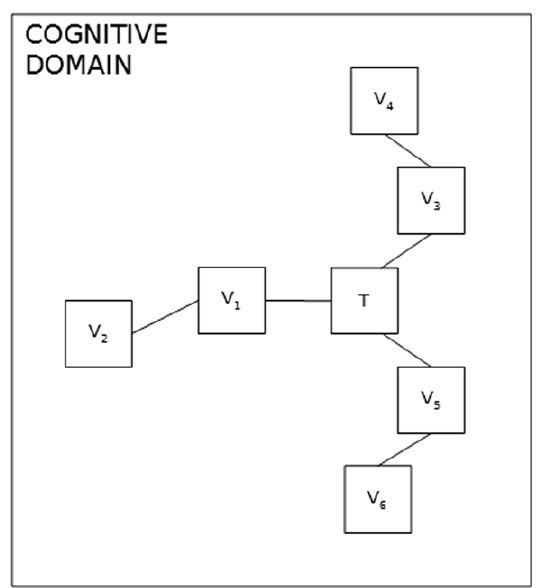
Figure 1: Network of contiguity relations (author’s own